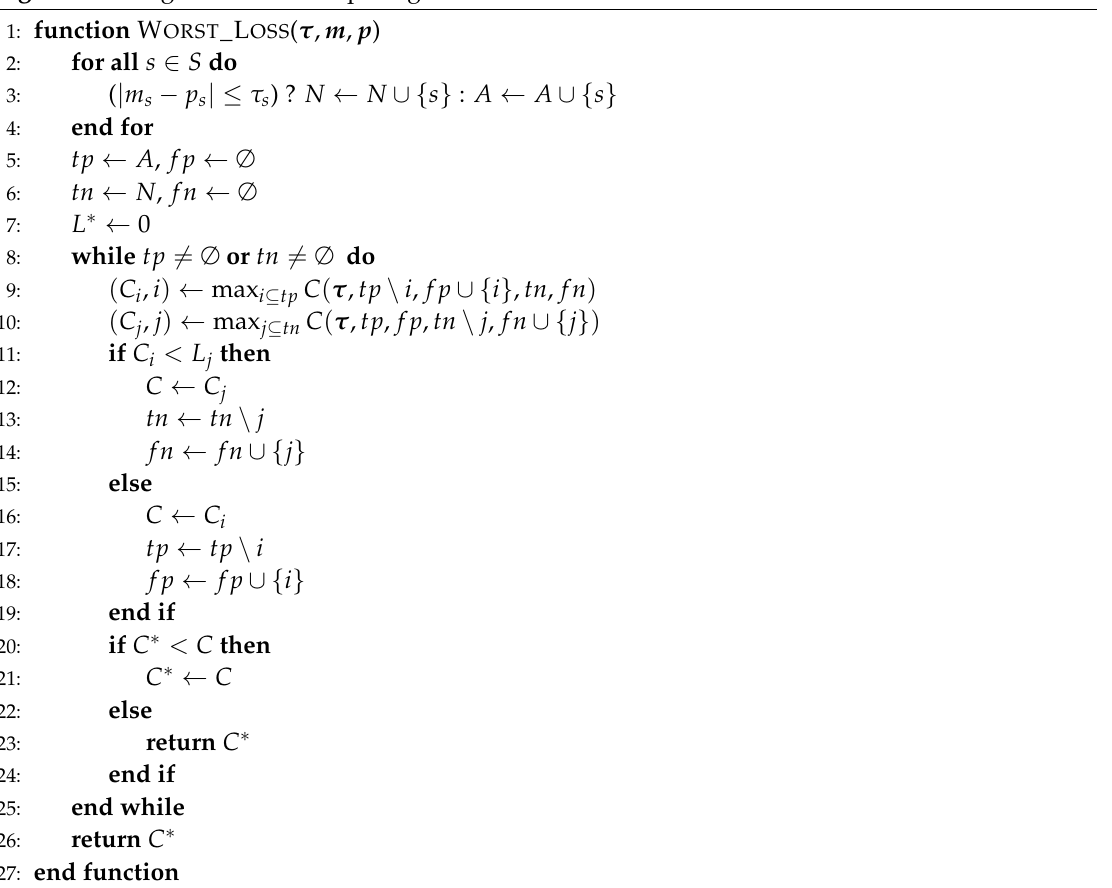
Algorithm 2 Algorithm for Computing Worst-Case